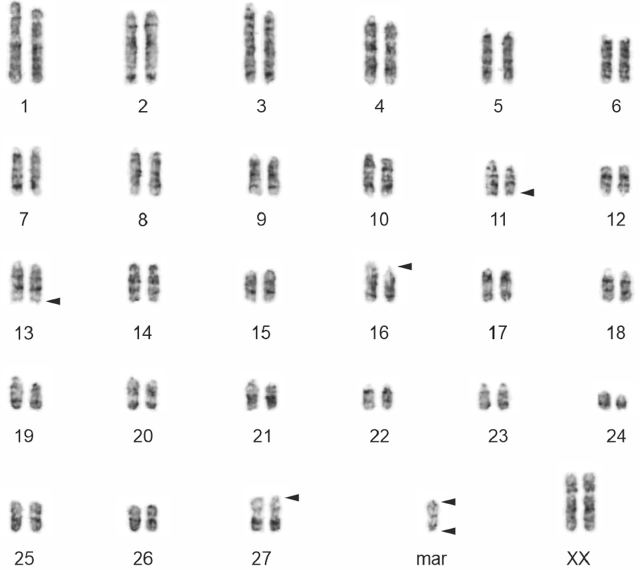
Figure 3. C ‐ banded chromosomes of E. maximus (2n = 57,XX,+mar).